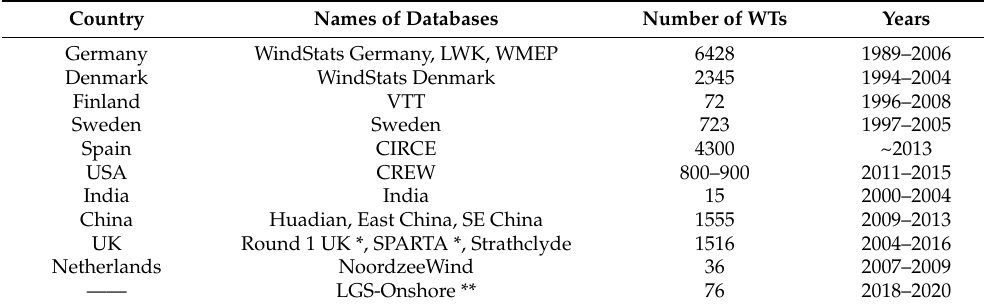
Table 1. Databases of wind